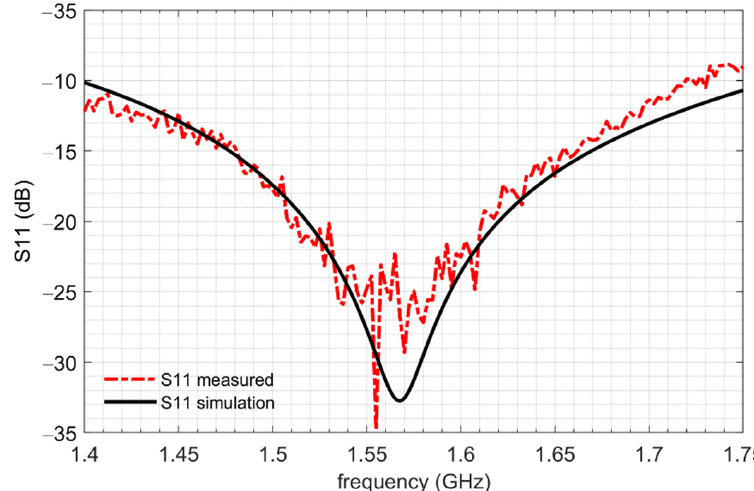
Figure 24. Comparison of measured and simulated input impedance matching (S11)—balun and mixer.